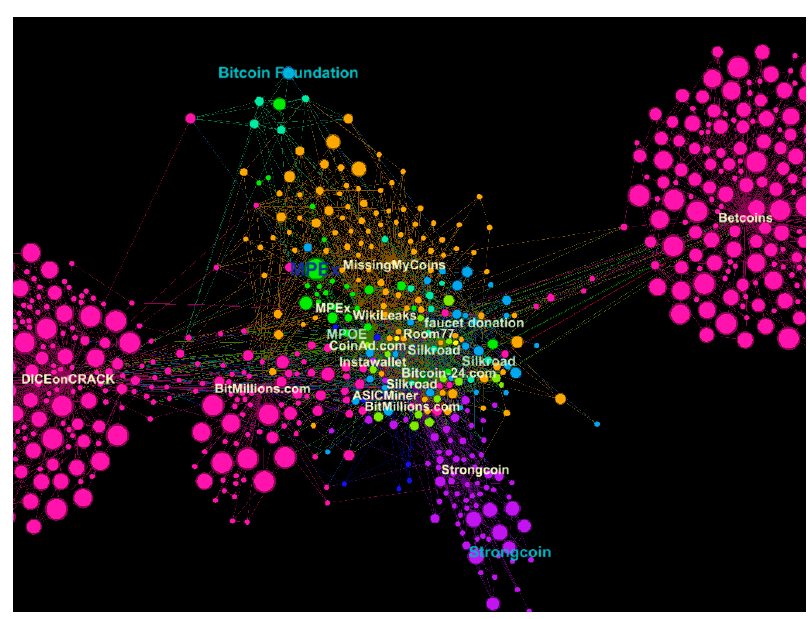
Figure 37. Visualization of the Clustering Coefficient in the Bitcoin Network. Future Internet 2016 , 8 , 7